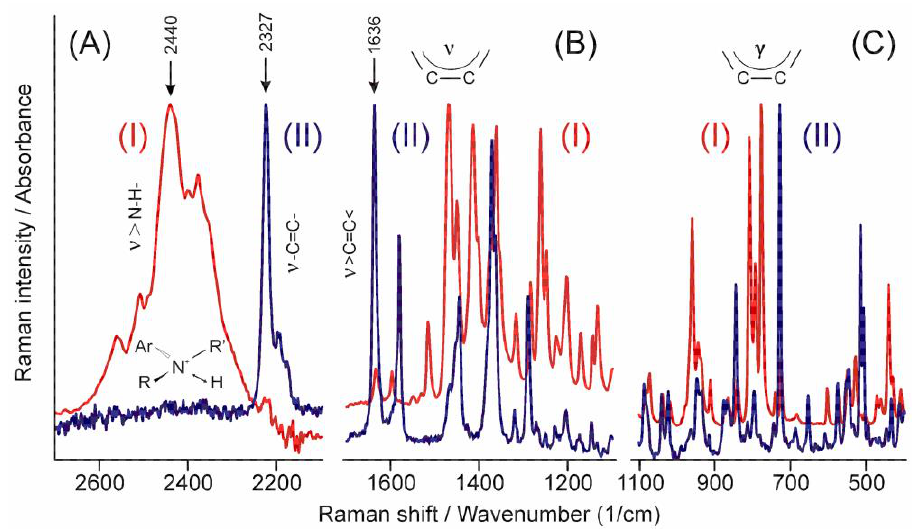
Figure 5. Comparison of the infrared (I) and the Raman (II) spectra of TER in certain characteristic regions. ( A ) stretching bands of +N-H and - C≡C - groups, ( B ) stretching bands of >C=C< group and the aromatic rings, ( C ) the out-of-plane deformation bands of the aromatic rings.